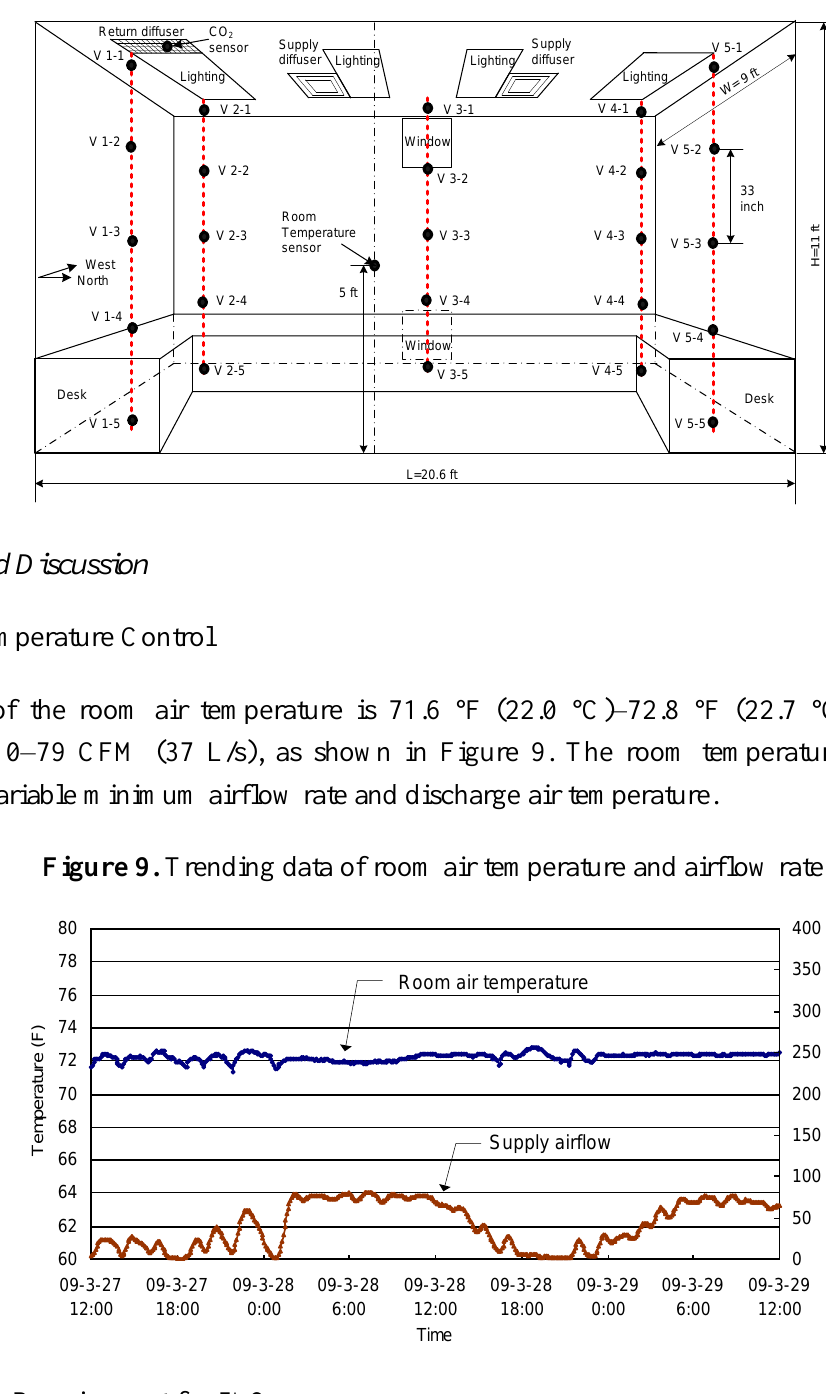
Figure 8. Measurement points for evaluations.